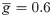
Relative root mean squared errors (RRMSE) (%) of CDS and strip transect estimators estimators (strip widths ranging from 0 to 1) of N, for 4 detection functions, with E[n] = 200, P = 0.1 and g¯=0.6.